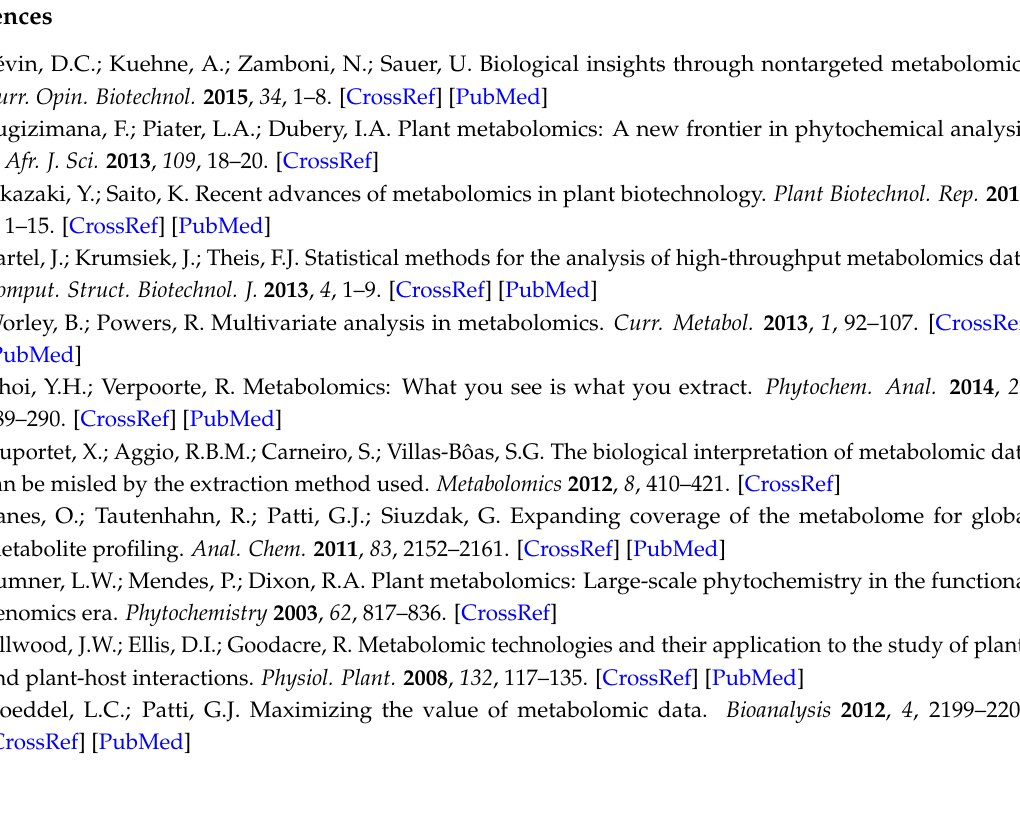
Figure S1: PCA scores and DModX plots (of Methods 2 and 3 in Table 2), Figure S2: Hotelling’s T 2 range plots of the four PCA models ( Methods 1 to 4 in Table 2), Figure S3: DModX and a typical contribution plots (of PCA models for the Method 1 data set), Figure S4: OPLS-DA scores plots, Figure S5: DModX plots for the detection of moderate outliers, Figure S6: Predicted scores plots and DModXPS, Figure S7: The Coomans’ plots—distance to model predicted (DModXPS+) of two